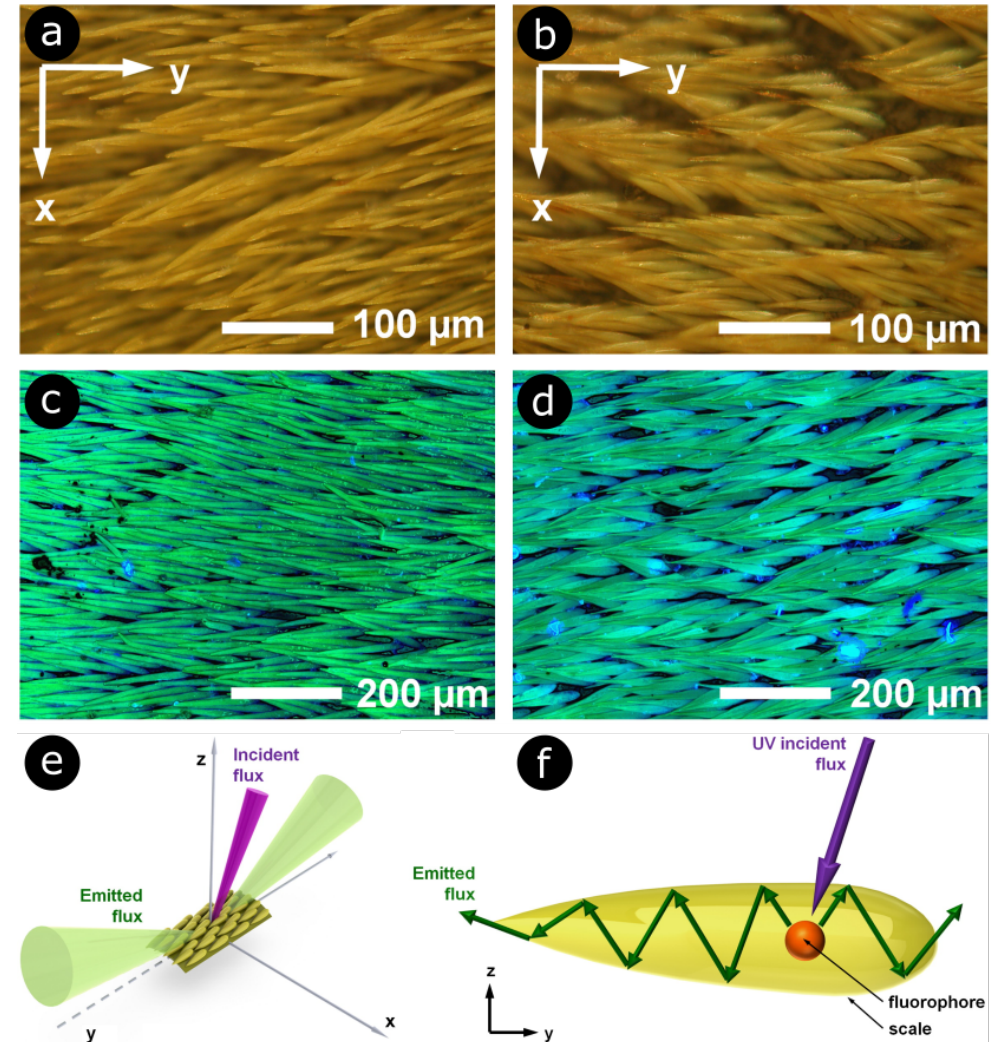
Figure 5. The elytra of longhorn beetles Celosterna pollinosa sulfurea and Phosphorus virescens are covered by elongated scales, in which fluorophores are embedded. These scales act as waveguides for the light emitted by the fluorophores. They display a yellow colour under visible light for C. pollinosa sulfurea ( a ) and P. virescens ( b ) (here, observation by optical microscopy). Under UV light, the observed colour is turquoise in both respective cases ( c , d ). Upon illumination with UV light (represented in magenta), embedded fluorophores mostly emitted within two emission cones (in green) ( e ) due to a waveguide effect taking place within the scales ( f ). Reproduced from Van Hooijdonk, E.,